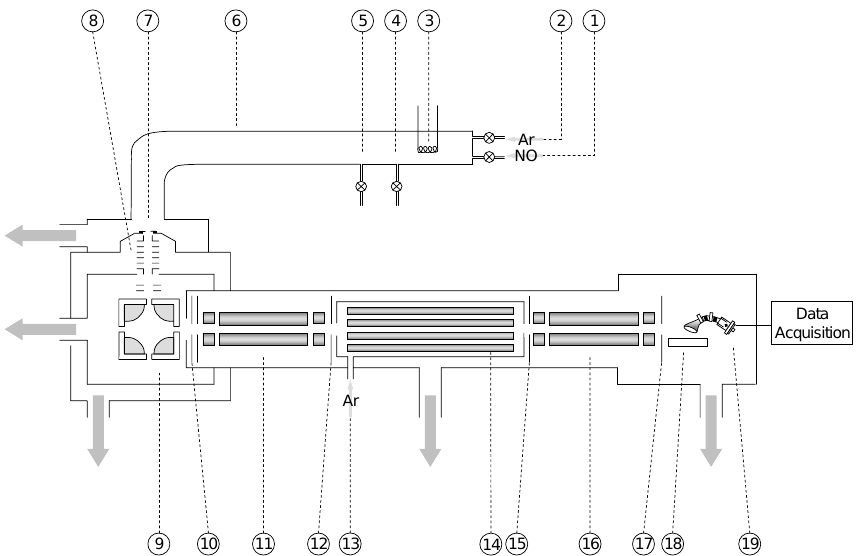
Fig. 1. Schematic representation of the FA-TMS instrument. Light grey arrows indicate regulated gas flows entering the instrument, dark grey arrows indicate gas flows exiting the instrument towards the pumping systems. (1) NO inlet, (2) Argon inlet, (3) electron emitting filament, (4–5) neutral inlets (H 2 O, SQT), (6) flow tube (FT), (7) interface plate, (8) lens system, (9) ion deflector, (10) entrance lens to first quadrupole, (11) first quadrupole with pre- and post filter, (12) lens between first quadrupole and octupole, (13) argon collision gas inlet, (14) octupole collision cell, (15) lens between octupole and second quadrupole, (16) second quadrupole with pre- and post filter, (17) exit lens, (18) discrete dynode, (19) electron